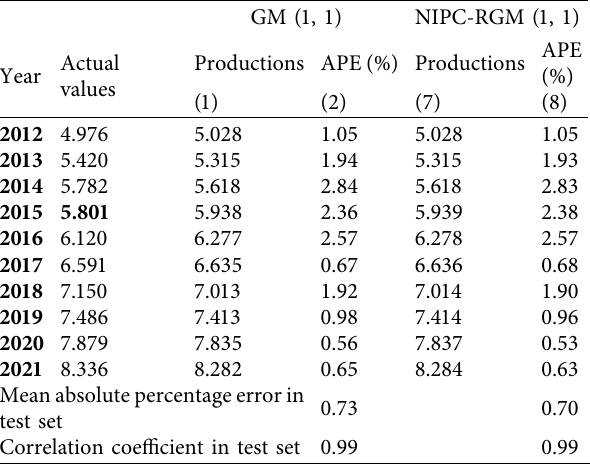
Table 2: | Predictions from existing and new models without an outlier.